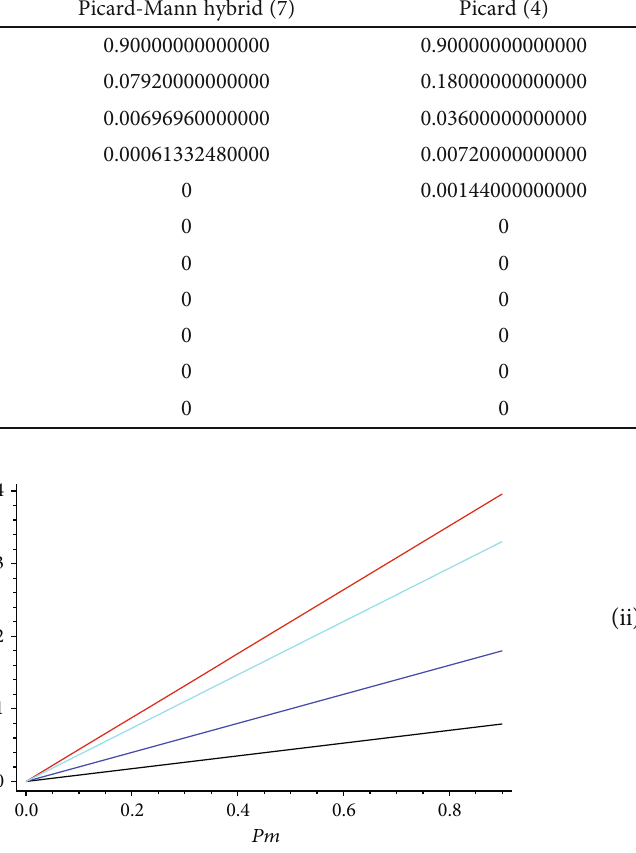
Figure 1: Behaviors of Picard-Mann hybrid (black), Picard (blue), Ishikawa (cyan) and Mann (red) iterates to the unique fi xed point e = 0 of the selfmap S 0